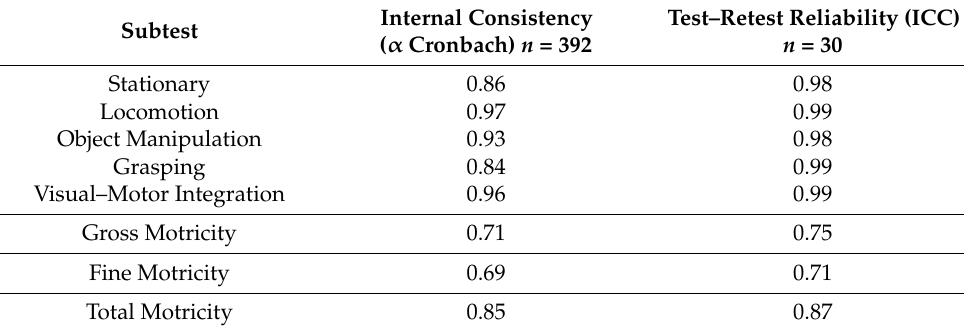
Table 3. Internal consistency and test–retest reliability of